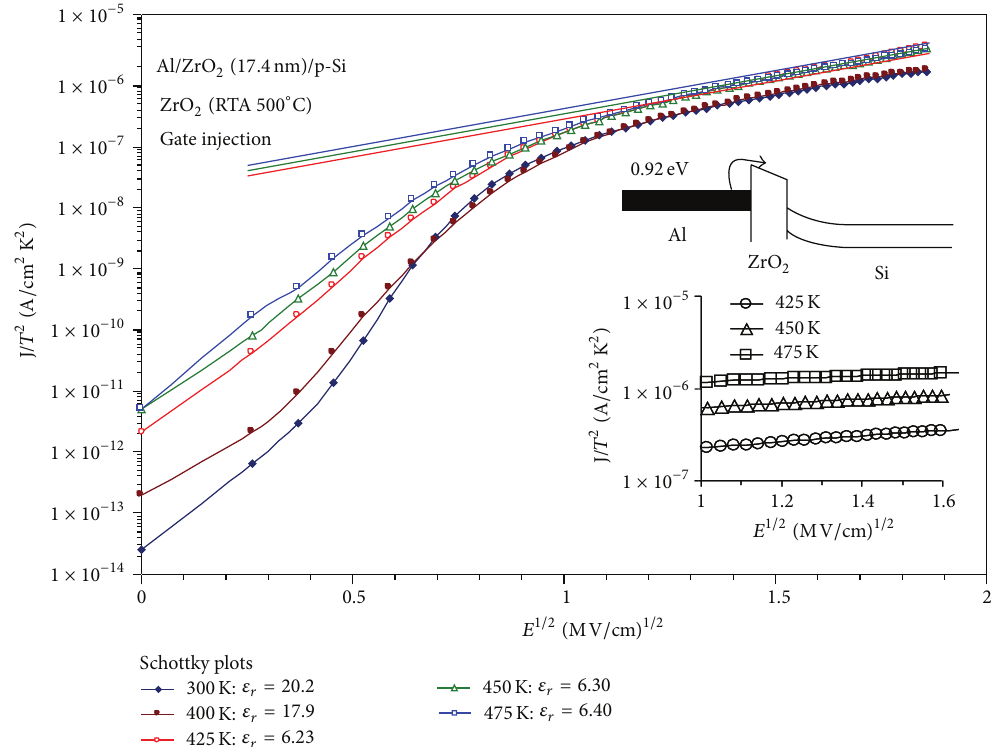
Figure4:CharacteristicsofstandardSchottkyemissionatvarioustemperatures.InsetgraphspresentstandardSchottkyemissionconstrained by 𝑛 = 𝜀 1/2 𝑟 at high temperatures; the band diagram is also